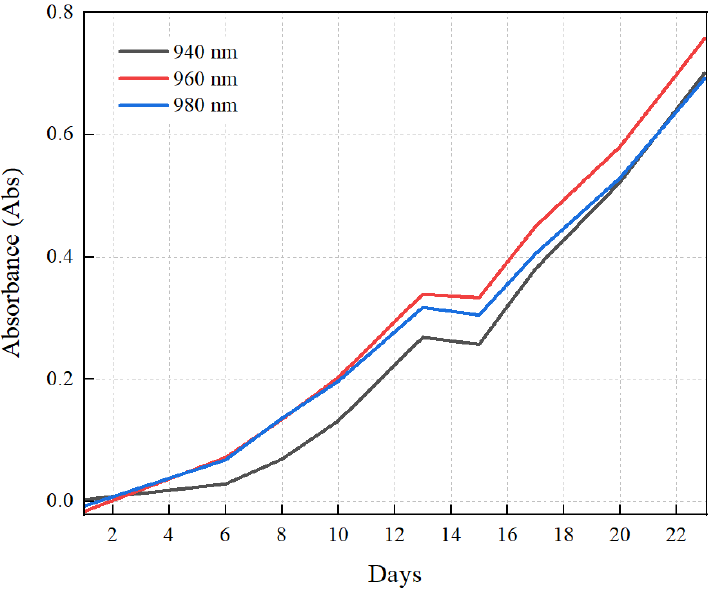
Figure 3. Comparison of absorbance of NS6 at 940, 960, and 980 nm as a function of the days since the start of growth.